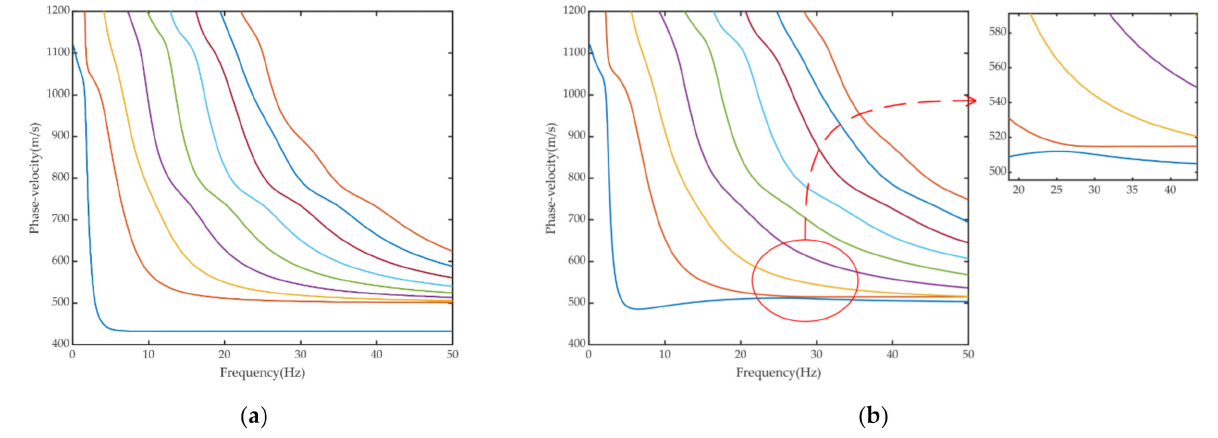
Figure 6. The dispersion curves of the first nine modes of ( a ) Model 1 and ( b ) Model 2.